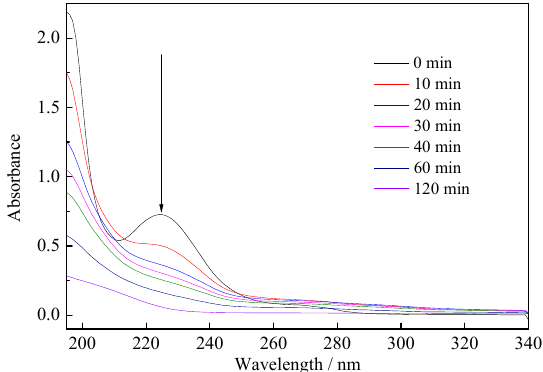
Figure 8. UV-Vis absorbance spectra of benzohydroxamic acid solution at different irradiation times.